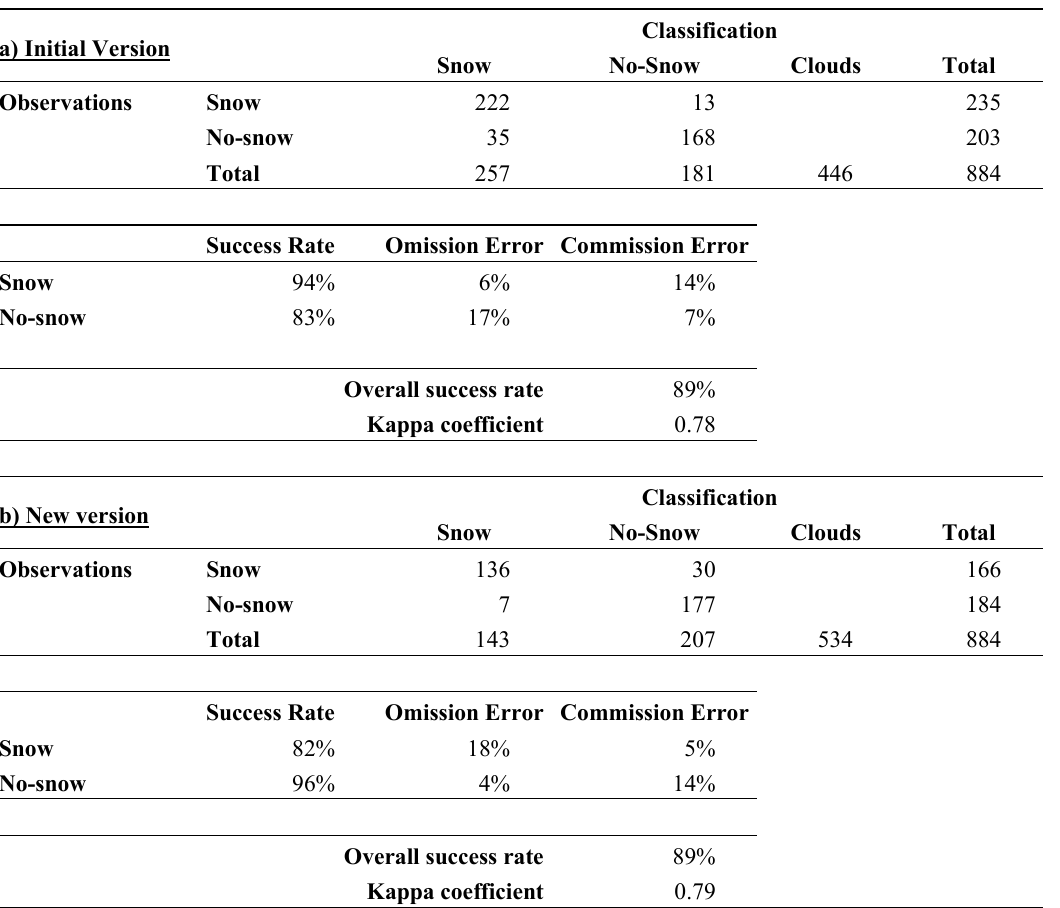
Table 4. Validation of the two versions of the AVHRR algorithm using the same ground snow observations from 15 meteorological † stations for 1987, 1992 and